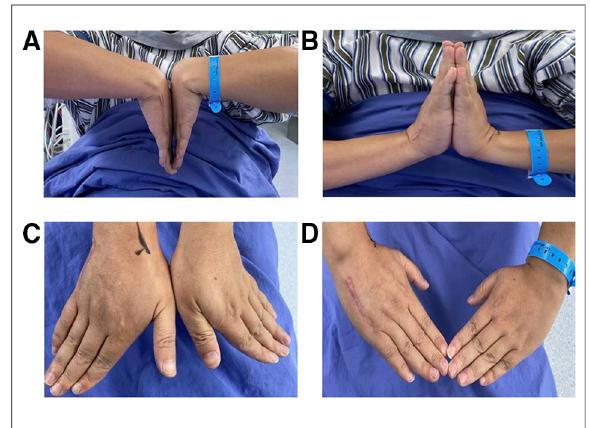
FIGURE 2 The range of motion of bilateral wrists of a patient in the last follow- up. ( A ) The appearance of the extension position. ( B ) The appearance of the fl exion position. ( C ) The appearance of ulnar deviation position. ( D ) The appearance of radial deviation